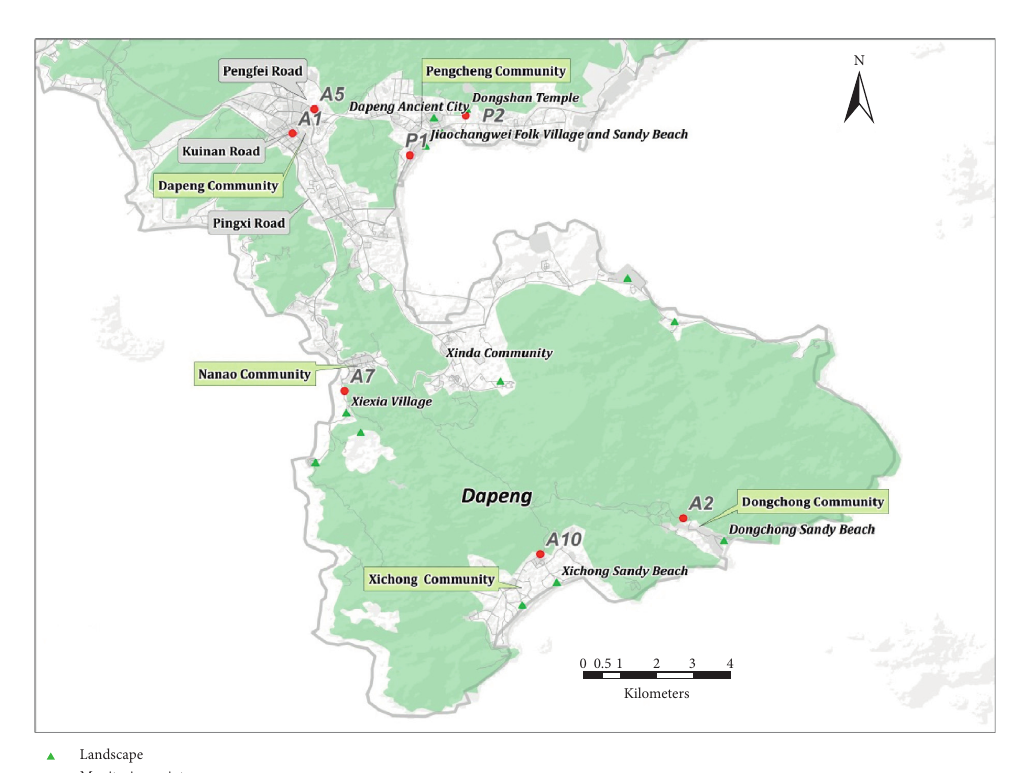
Figure 2: Distribution of monitoring points for tourist traffic